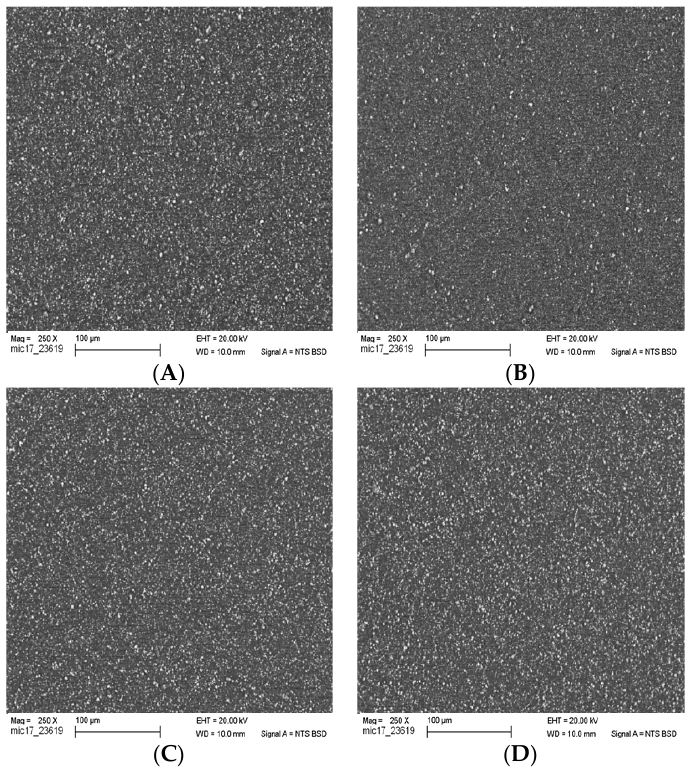
Figure 5. SEM images of morphology of PA-CaCO 3 composites: ( A ) 1% amino hexanoic acid treated; ( B ) ε -caprolactam treated; ( C ) L -arginine treated; ( D ) glutamic acid treated.